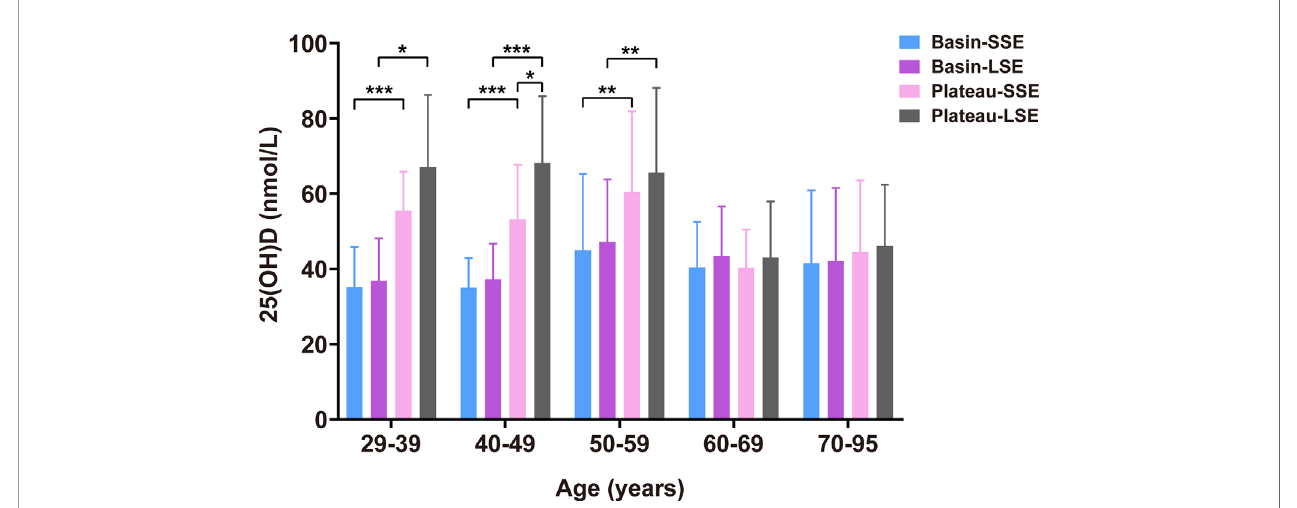
FIGURE 3 | Serum 25(OH)D levels strati fi ed by region, age and sunlight exposure duration. SSE, short sunlight exposure, <3 hours daily; LSE, long sunlight exposure, ≥ 3 hours daily. Models were adjusted for BMI, education level, exposed site, sun protection, and living in rural/urban area. * P < 0.05; ** P < 0.001; *** P < 0.0001.